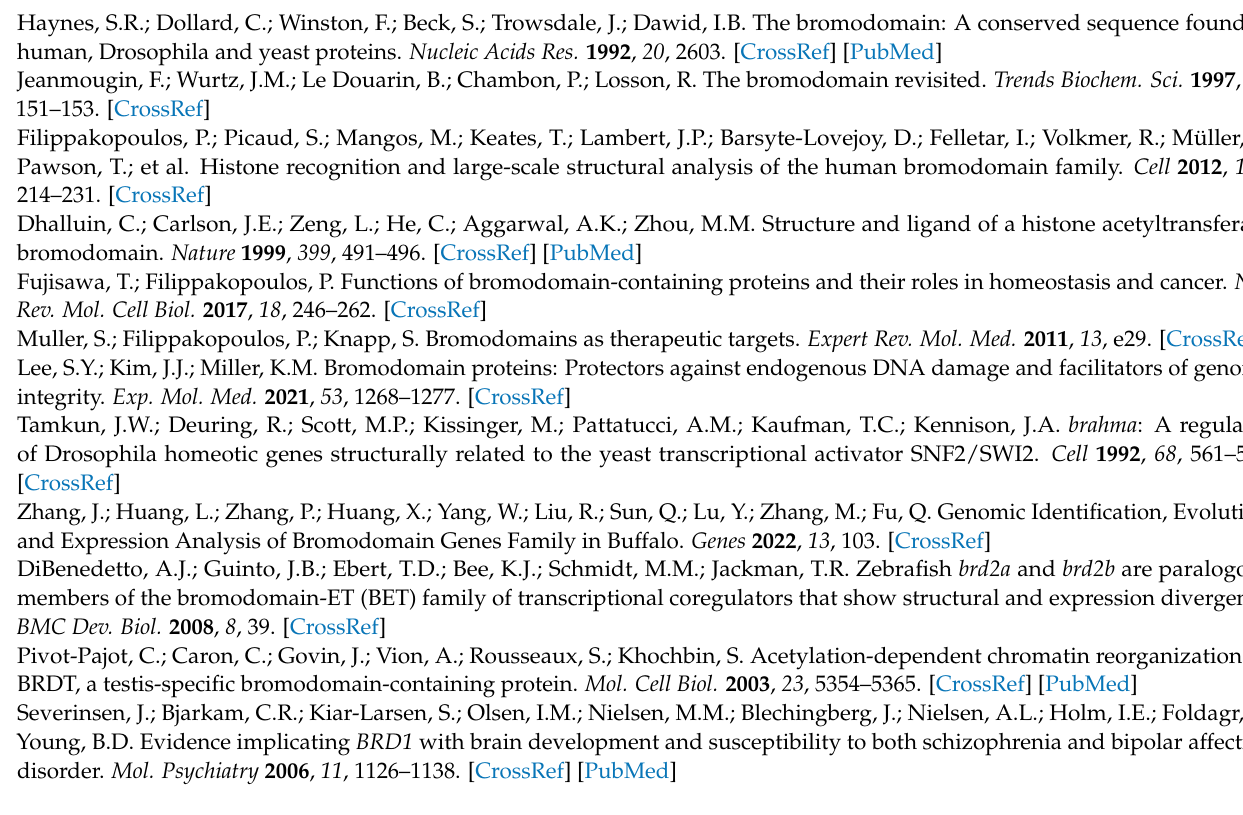
Table S1: The accession numbers of BRDs isolated. Table S2: Primers used in the present study. Table S3: The sex-dimorphic genes expressed in XX and XY gonads. Table S4: The contig N50, Table S5: Chromosome distribution of BRDs in different